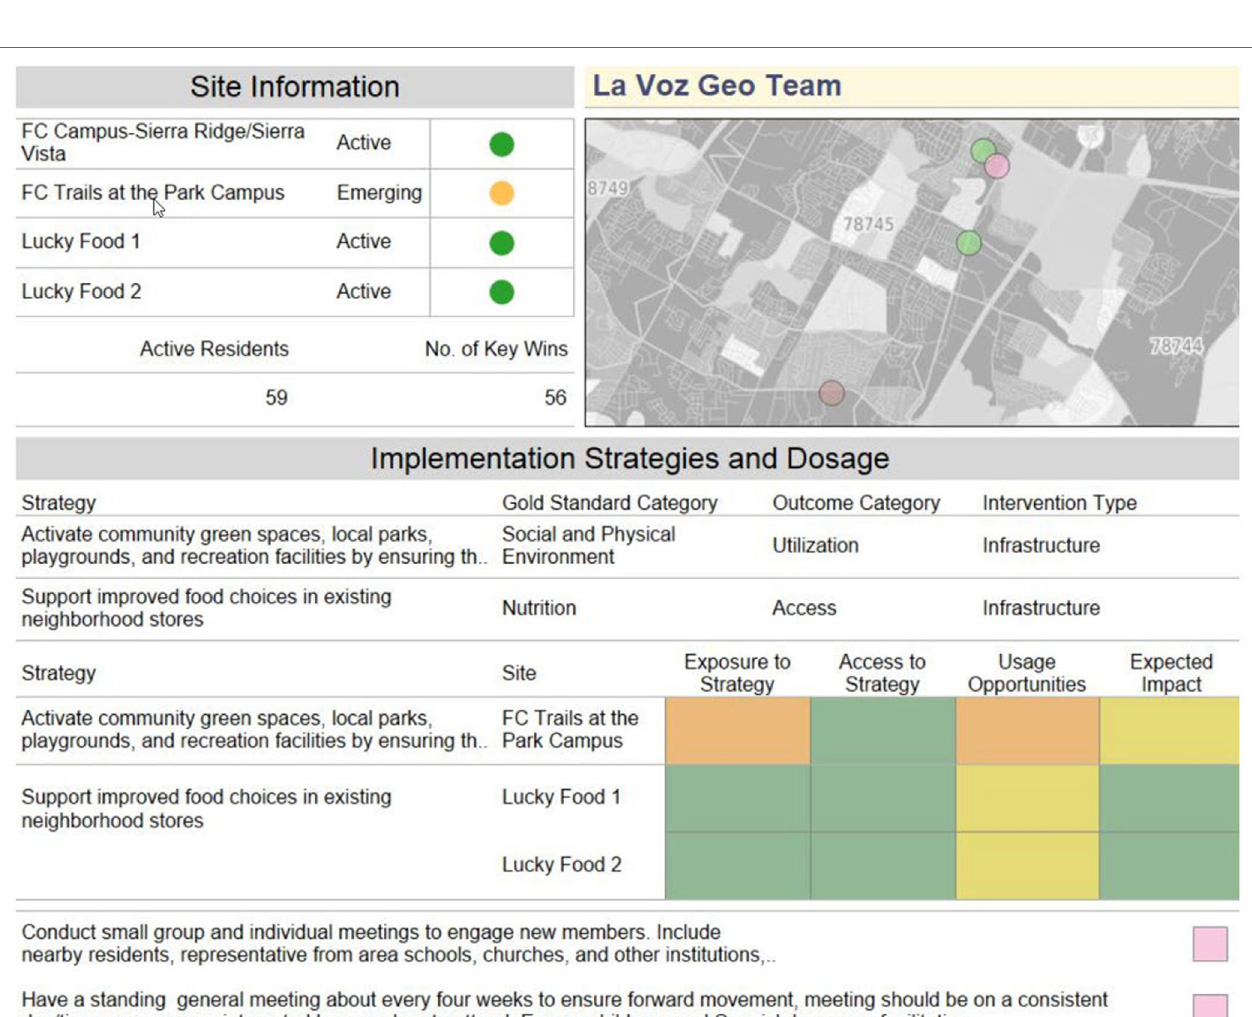
FiGuRE 1 | Example of site-specific dashboard data presented at monthly